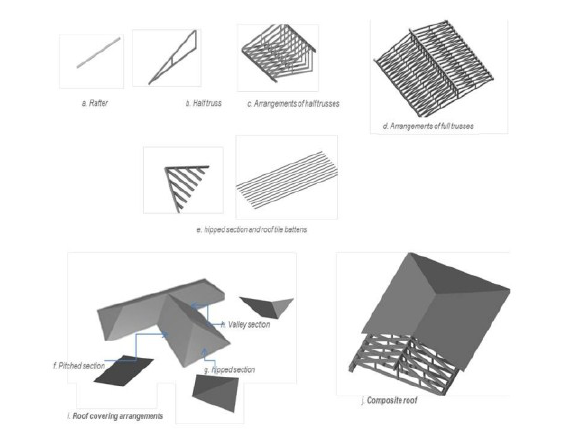
Figure 3: Parametric Roof